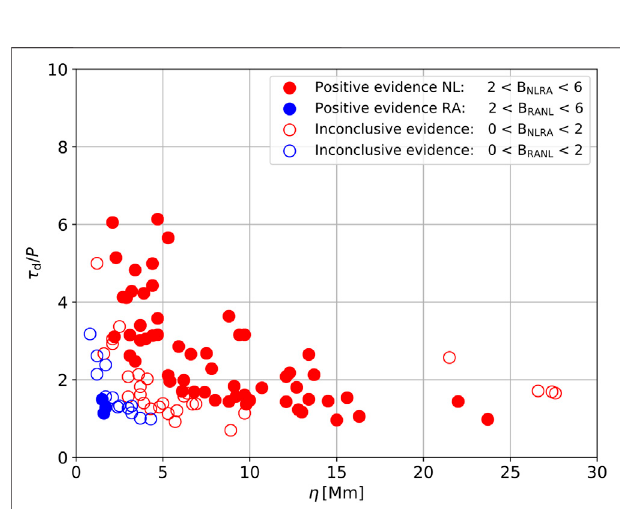
FIGURE 11 | Scatter plot of the 101 loop oscillation events in the Nechaeva et al. (2019) catalog with information about both the oscillation amplitudeand thedampingratio.IntheBayesian evidenceanalysisbyArregui (2021), colour fi lled circles represent cases with conclusive evidence. Edge coloured circles represent cases with either p ( D | M NL ) > p ( D | M RA ) or vice versa, yet inconclusive evidence. Red is for M NL and blue for M RA . Adapted from Arregui